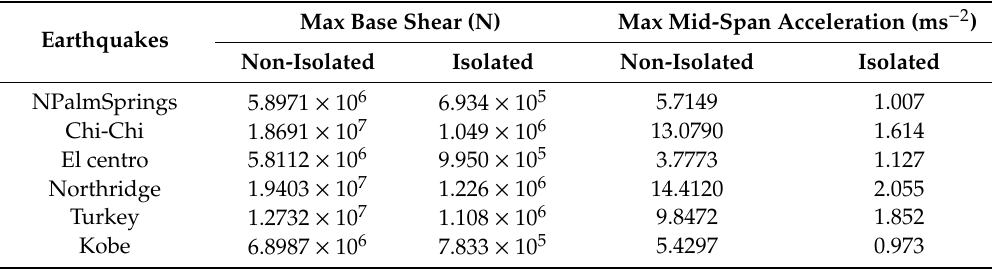
Table 8. Max base shear and mid-span acceleration of the bridge before and after isolation.